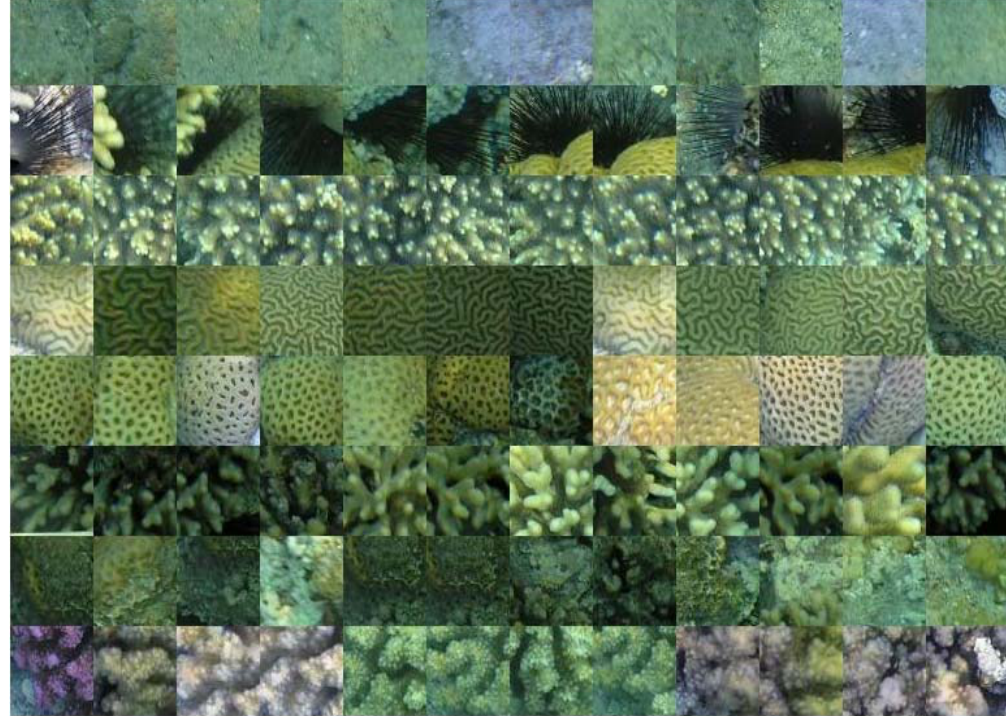
Figure 3. Example images patches from the EILAT dataset showing 12 examples (in columns) of each of the eight classes (in rows, from top to bottom: sand, urchin, branches type I, brain coral, favid coral, branches type II, dead coral and branches type